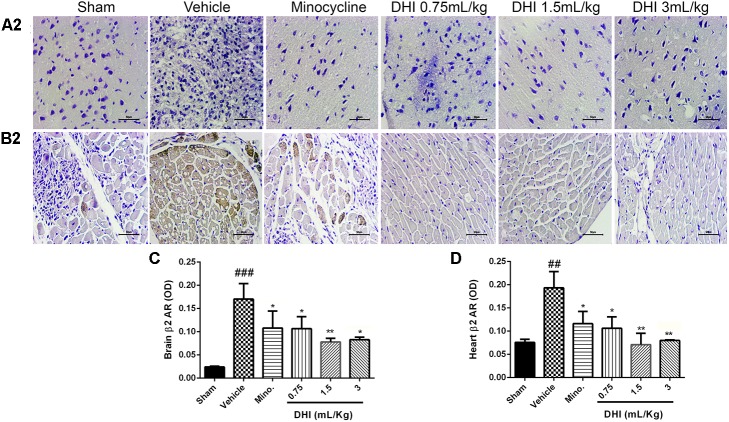
Danhong injection treatment adequately ameliorates β2-AR accumulation remotely in brain and heart of Wister rats. (A2,B2) Are photomicrographs of the brain and heart β2-AR assayed in IHC. (C,D) Quantification of β2-AR for brain and heart respectively. There are highly congested brownish patches in the brain (A2) and heart (B2) from the vehicle (###p < 0.001 and ##p < 0.01 vs. sham) but greatly reduced in drug treatment groups (∗p < 0.05 and ∗∗p < 0.01 vs. vehicle), respectively (n = 3 in each group, image scale bar = 50 μm). Data are presented as mean ± SEM.